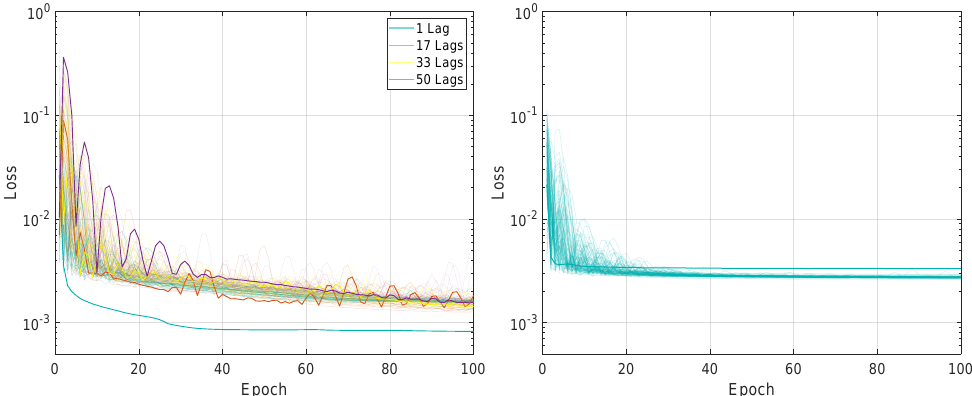
Figure 2. Illustration of the training loss for Experiment 1, LSTMTF ( left ) and VLSTM ( right ), using a many-to-many prediction mode. For each architecture, the lines with the same colors represent the loss for networks trained with the sequence length in the range [1:500]. The highlighted thick lines represent the training loss for a sequence length of